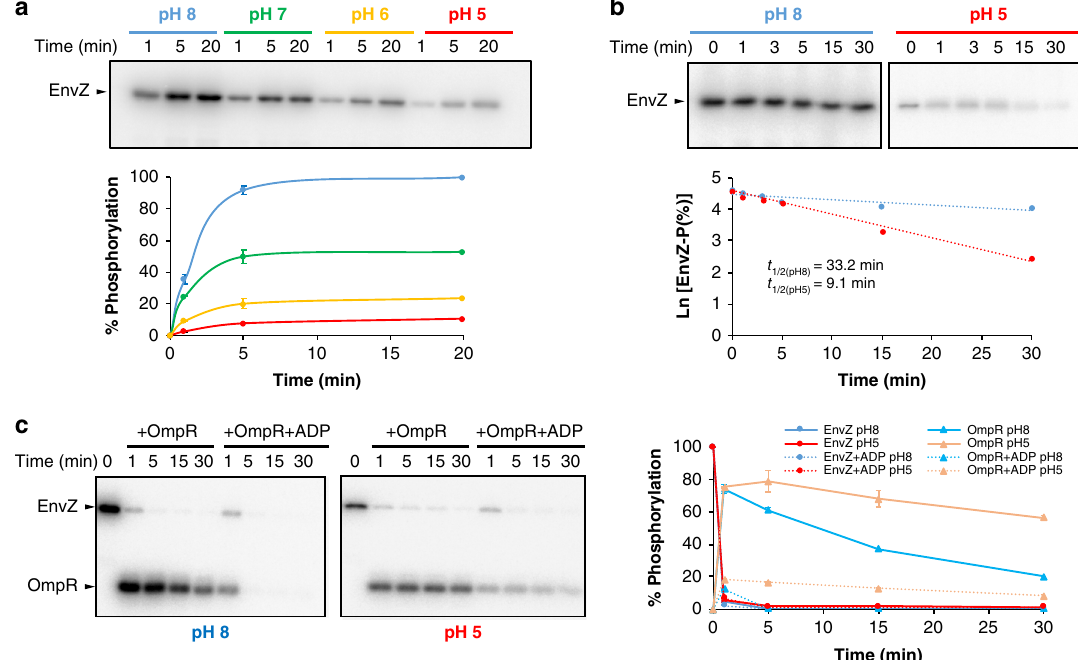
Fig. 6 Autophosphorylation of EnvZ and phosphotransfer to OmpR. a Time course of EnvZ autophosphorylation with [ γ - 32 P] ATP at different pHs. b Stability of phosphorylated EnvZ at acidic (5) and basic (8) pH. Half-life plots for each pH is shown. c Phosphotransfer of phosphorylated EnvZ to OmpR at acidic (right) and basic (left) pH in the absence and presence of ADP. Gels correspond to a representative experiment and quanti fi cation of three independent experiments are plotted. Error bars represent SD. Source data are provided as a Source Data fi